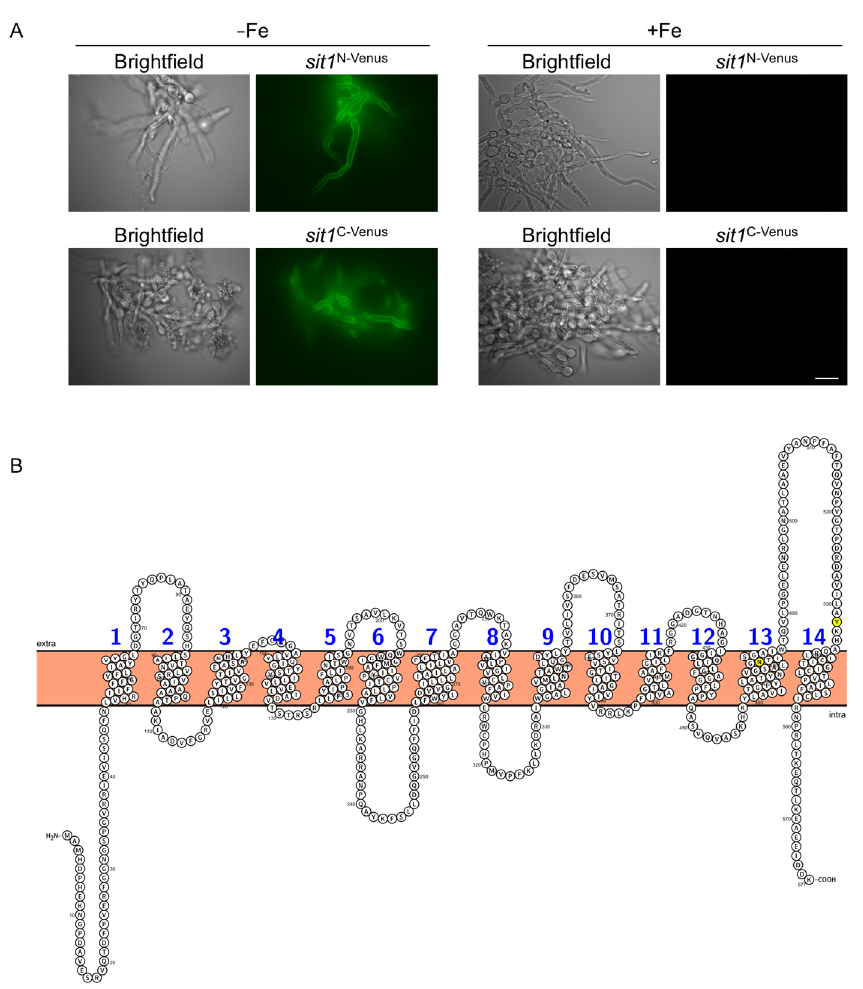
Figure 2. Sit1 is localized in the plasma membrane and its production is induced by iron starvation. ( A ) Epifluorescence microscopy of A. fumigatus sit1 N-Venus and sit1 C-Venus strains was performed as described in Materials and Methods; scale bar is 20 µm. ( B ) Schematic illustration of the Sit1 membrane topology according to Protter [44]. The point mutations rendering A. fumigatus resistant to VL-2397, N479K [46], and impairing Sit1 activity in C. glabrata , Y575A [47], are highlighted in yellow. Table 2. Venus-tagging of Sit1 affects VL-2397. The minimum inhibitory concentration (MIC)